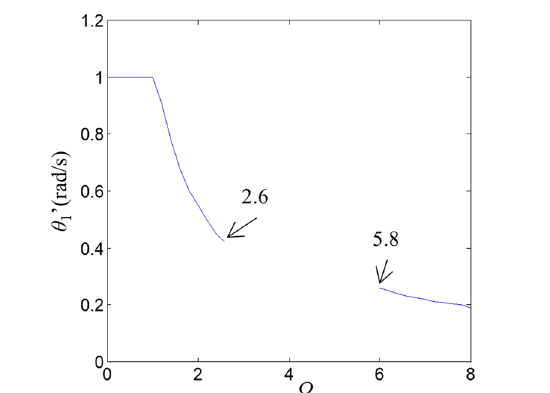
Figure 4 Change of θ ′ 1 with Ω (The unmarked part indicates that θ ′ 1 is in a surge